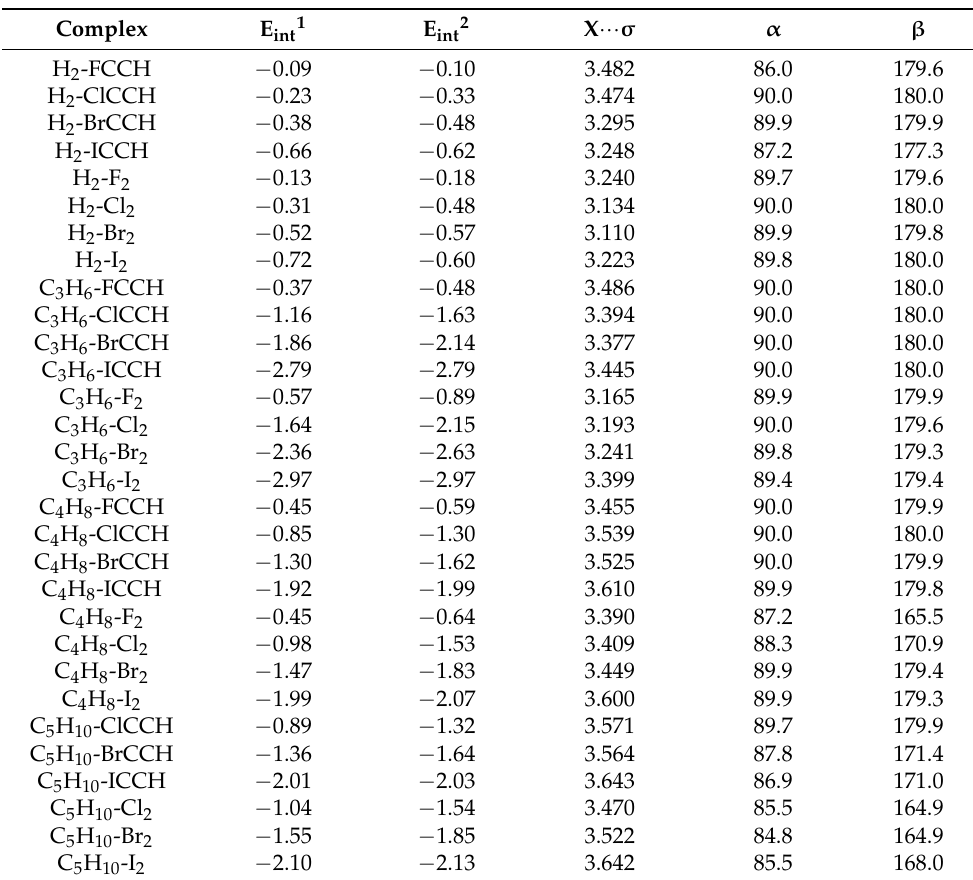
Table 2. The characteristics of interactions in complexes analysed: interaction energy corrected for BSSE (in kcal/mol)—E int1 , and E int2 are specified; the distance between the halogen centre and the midpoint of the H–H or C–C bond (in Å)—X · · · σ ; as well as α and β angles defined in Scheme 3 (in